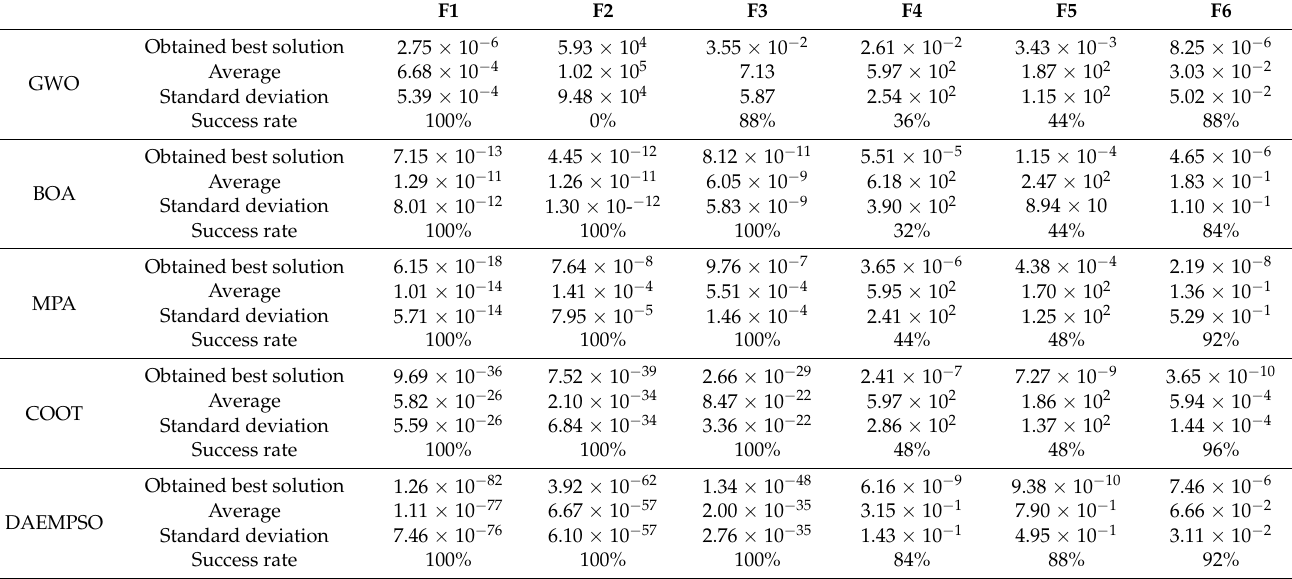
Table 7. Comparison of the optimization results of five algorithms for six test functions (1000 dimensions).